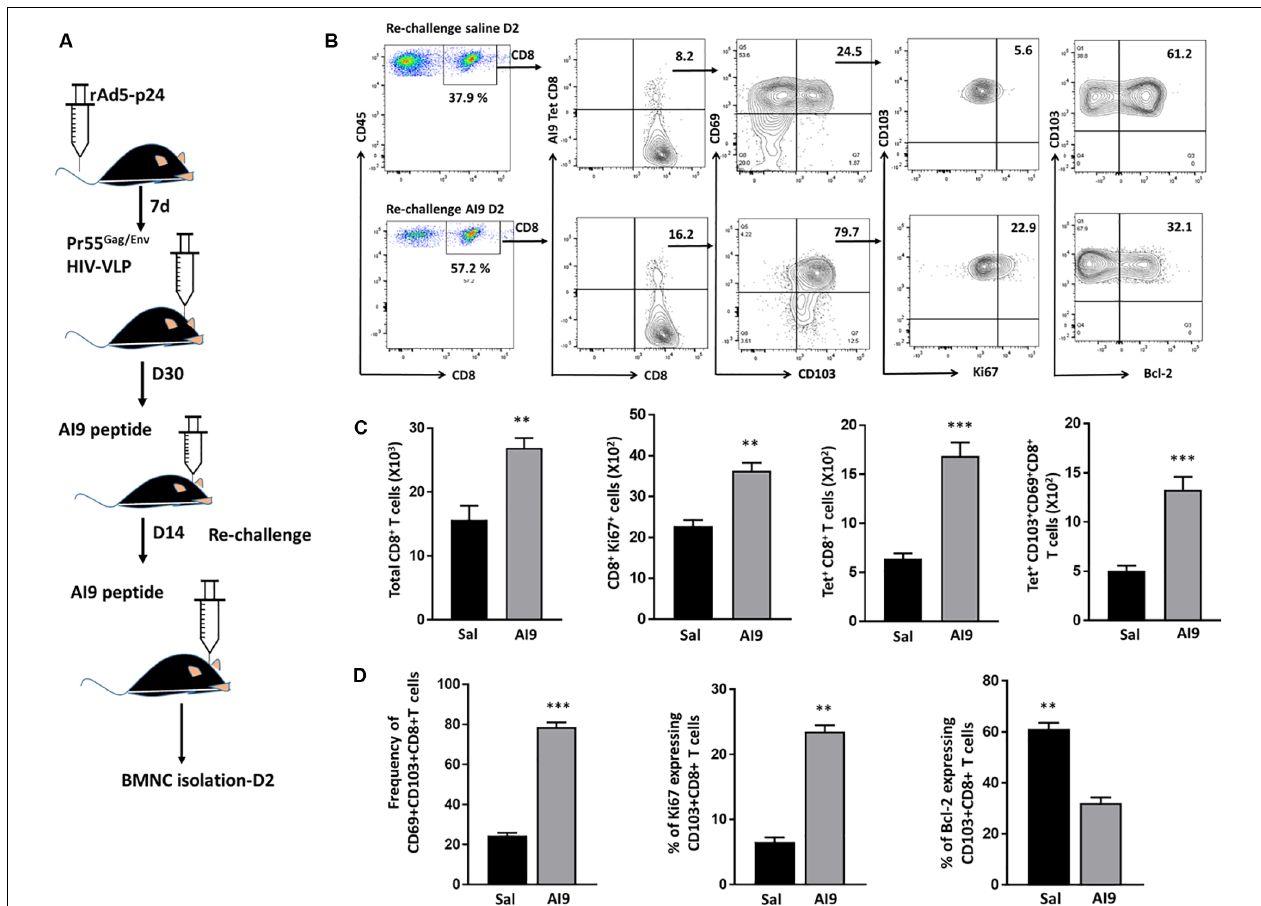
FIGURE 1 | Ag-specific CD69+CD103+CD8+ brain resident-memory T-cells persisted and proliferated in response to re-challenge. (A) Schematic of the experimental design illustrates intravenous delivery of recombinant adenovirus vectors expressing HIV-1 p24 capsid protein (rAd5-p24), followed by a CNS-boost consisting of intracranial injection of HIV-VLPs into the striatum. Thirty days later, in vivo challenge was performed by injecting cognate antigen (AI9 peptide) or saline (controls) into the brain. Subsequent re-challenge was performed at d 14 post-challenge. BMNC were collected at d 2 post re-challenge. (B) Representative flow cytometry plots show the expression of CD8+ T-cells, tetramer-specific CD8+ T-cells, tetramer-specific CD69+CD103+CD8+ bT RM, Ki67 (i.e., proliferating cells) as well as Bcl-2 (i.e., survival marker) expression on tetramer-specific CD69+CD103+CD8+ bT RM at d 2 post-AI9 re-challenge (bottom panel of contour plot), and saline control (upper panel). (C) Absolute numbers of brain infiltrating CD8+ T-cells, proliferating CD8+ T-cells, tetramer-specific CD8+ T-cells, and Ag-specific CD69+CD103+CD8+ bT RM were determined at d 2-post re-challenge. (D) Pooled data present the frequencies (mean ± SD) of Ag-specific CD69+CD103+CD8+ bT RM , percent proliferating, and percent expressing Bcl-2 among the re-challenge group at d 2. Data presented are representative of two separate experiments, each experiment used six animals per group per time point with brain tissue homogenates from two animals being pooled. ∗∗ p < 0.01 and ∗∗∗ p <